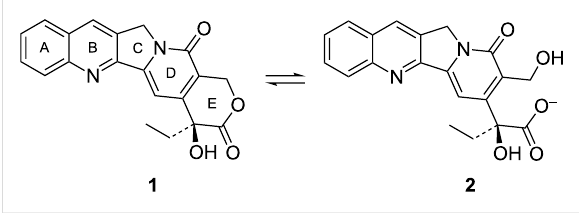
Figure 1: Molecular structure of (S)-(+)-camptothecin ( 1 ) and its inac- tive form ( 2 ) through lactone ring hydrolysis at physiological pH.